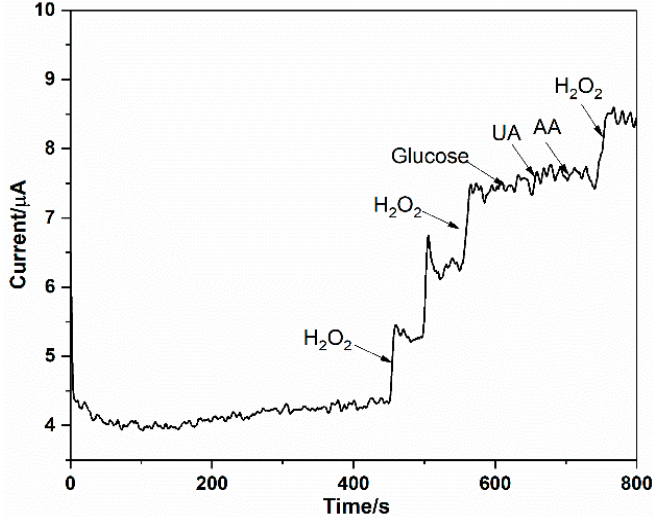
Figure 5. Current-time response curve at Ag-mSiO 2 /GCE for successive injection of H 2 O 2 , glucose, UA, AA in 0.2 M PBS at − 0.5 V .